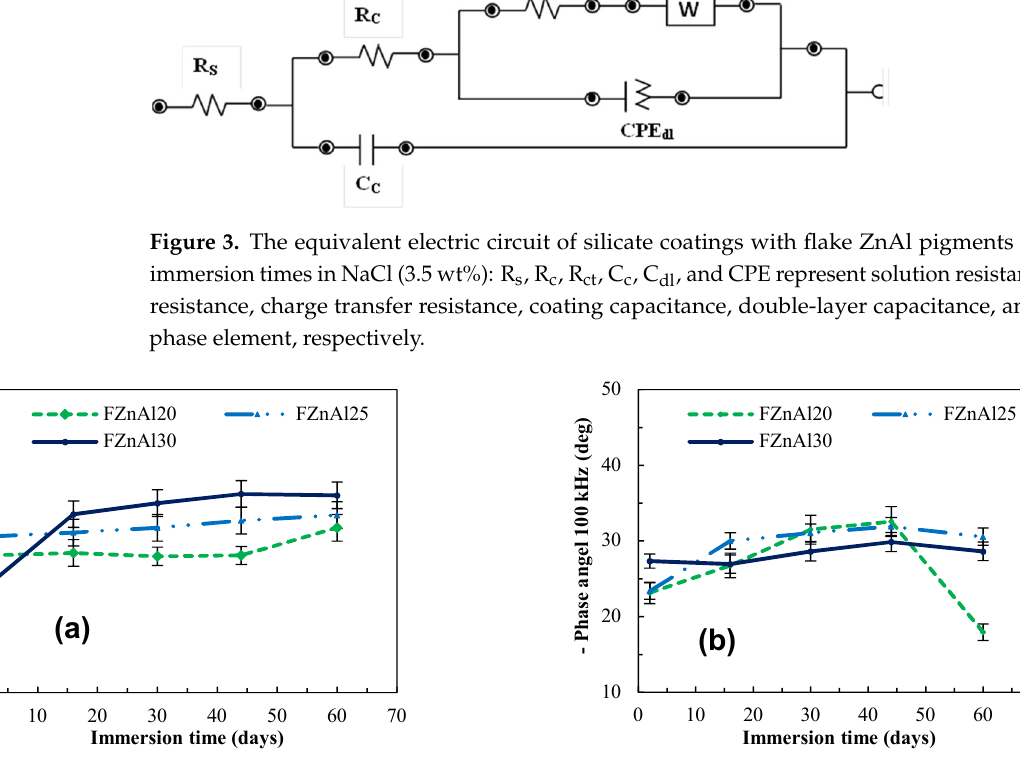
Figure 4. The plots of total impedance at low frequency (10 mHz) ( a ) and phase angle at high frequency (100 kHz) ( b ) versus immersion times for the silicate coatings, derived from the Bode plot.